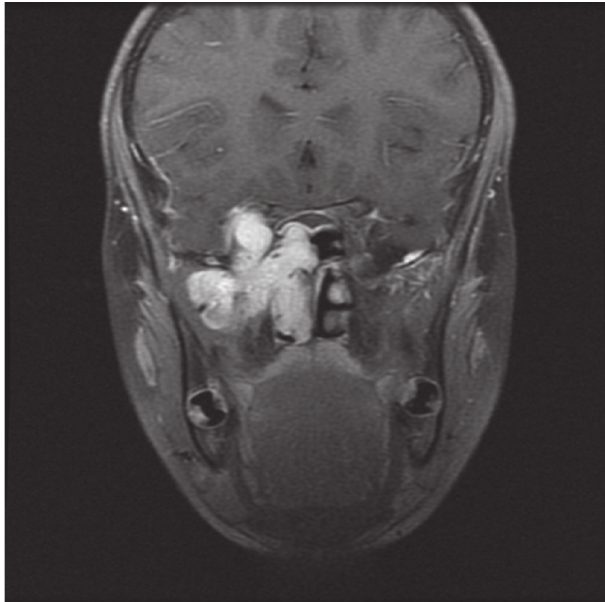
Figure 3 Magnetic resonance imaging (coronal view) of the same patient as Figures 1 and 2.